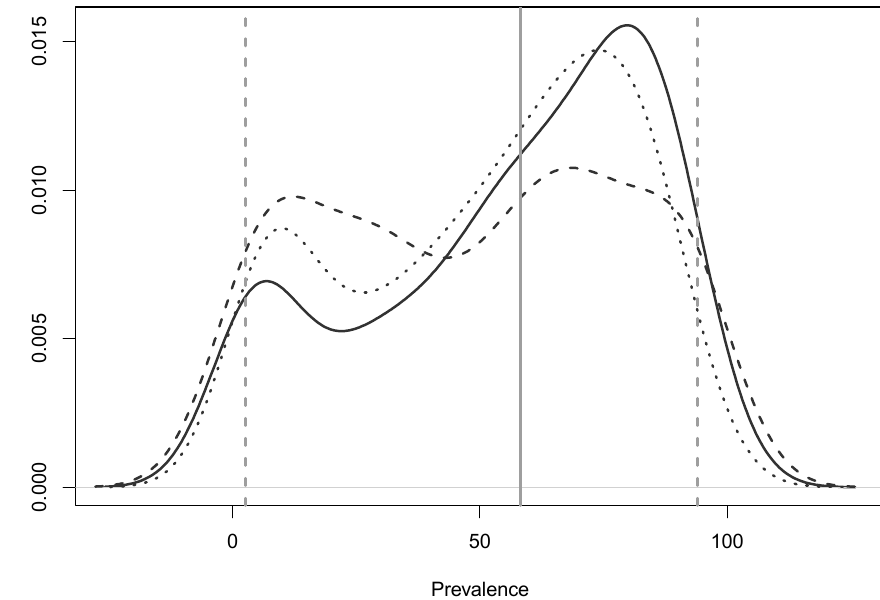
Figure 2. Density plot of the distribution of the estimated herd-level prevalence of bovine viral diarrhoea virus (BVDV) in beef breeder (black dotted line), beef rearer (black solid line) and dairy properties (dashed line) in a survey of veterinarians’ knowledge, attitudes and practices associated with BVDV management on properties in the temperate zone of south-east Australia in 2019. Vertical lines: grey solid = median combined between-property prevalence; grey dashed = 95% range of between-property prevalence. The extents of the plot <0 and >100 should not be interpreted; line extension is due to the smoothing process in constructing density plots.